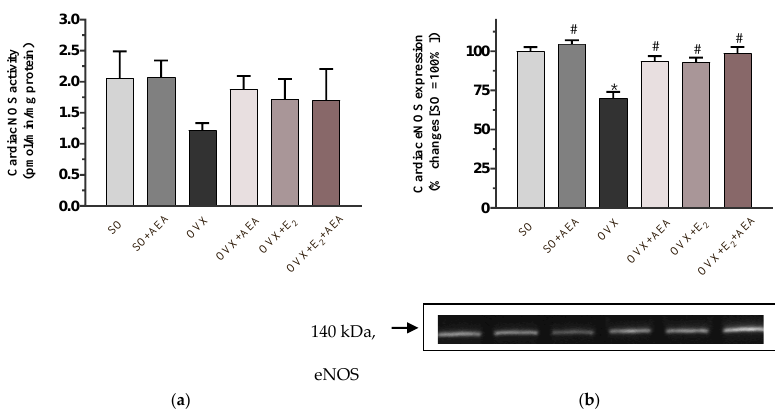
Figure 1. Effects of anandamide and estrogen treatments on cardiac activity and expression of the NOS enzyme in SO and OVX animals. ( a ) Cardiac NOS activity (expressed as pmol/min/mg protein); results are shown as means ± S.E.M. n = 6–8; ( b ) Representative image of cardiac eNOS expression (expressed as % changes, where SO = 100%); results are shown as means ± S.E.M. n = 5–9; * p < 0.05: statistical significance relative to the SO group, # p < 0.05: statistical significance relative to the OVX group. SO = sham operation, OVX = surgical ovariectomy, AEA = anandamide, E 2 = estrogen, NOS = nitric oxide synthase, eNOS = endothelial nitric oxide